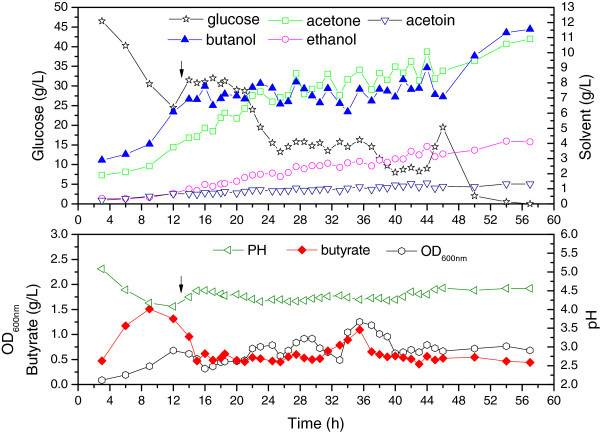
Kinetics of fed-batch fermentation in the biofilm reactor with fixed-bed adsorption. After 13 h of batch culture, concentrated medium was fed into the reactor to maintain desired glucose levels and the fixed-bed adsorption was started, as is indicated by arrows. Butanol was selectively adsorbed by the KA-I resin, whereas other solvents accumulated in the fermentation broth. OD, optical density.